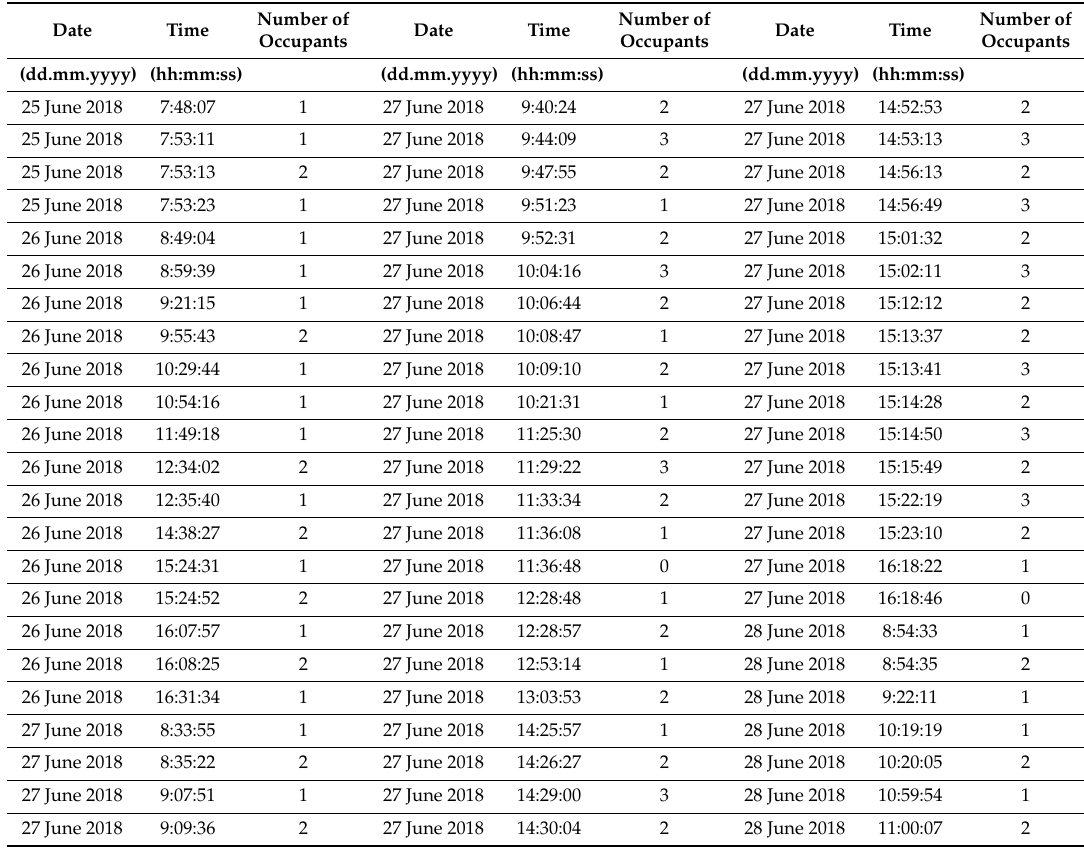
Figure 12. First floor of the recognition of the number occupants obtained from the measurement conducted in the period from 25 June 2018 (7:48:00), to 28 June 2018 (23:59:00). The number of occupants can be detected from the following Table 1: Table 1. Unambiguous determination of the number of occupants on the staircase in room R104 in the